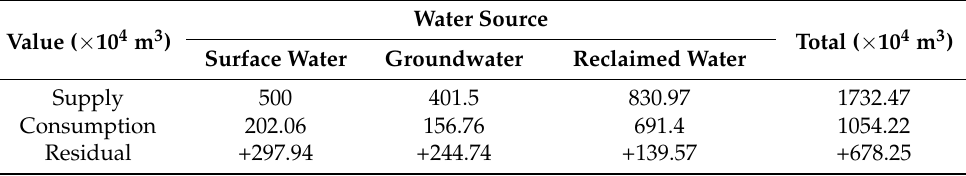
Table 5. Water resource supply and consumption in the study area in 2020. Residual = supply–